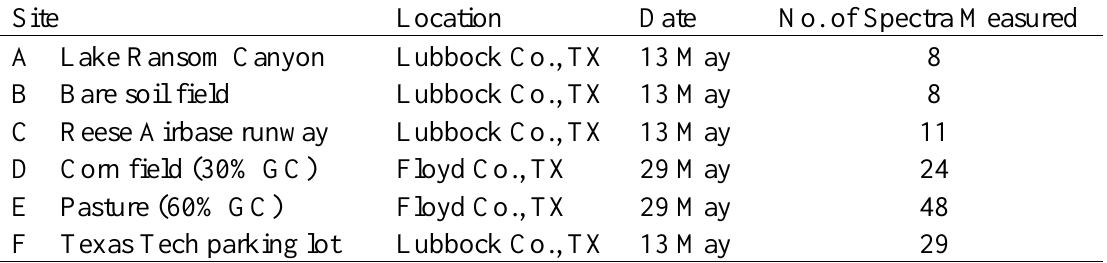
Table 3. The six ground sites used to validate the image conversion